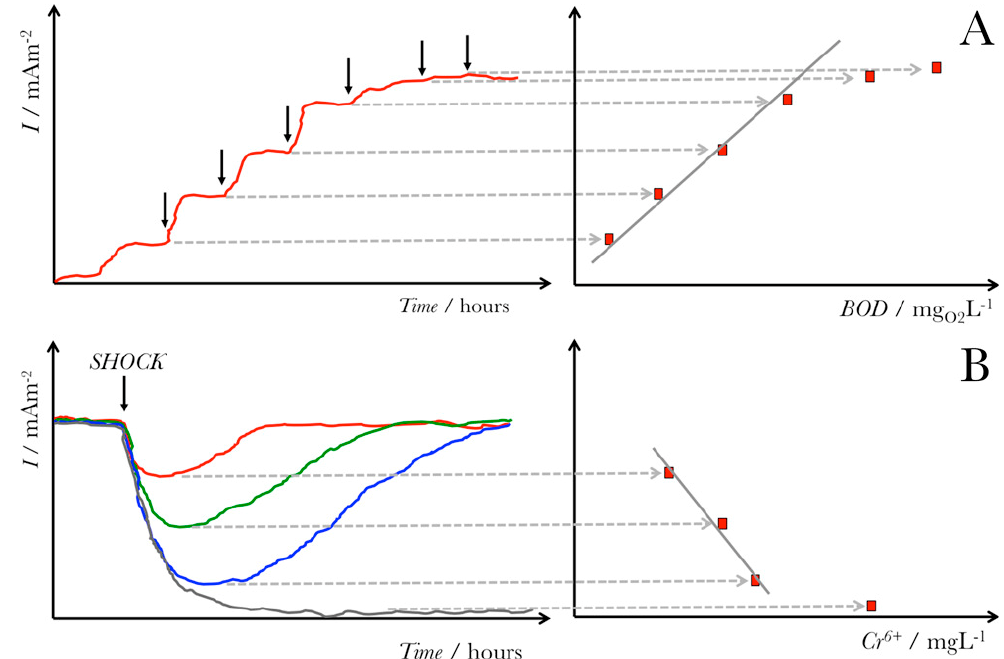
Figure 3. General scheme for microbial electrochemical sensors. Panel ( A ) shows how a microbial electrochemical sensor would work to sense the organic content of a solution, such as the biological oxygen demand (BOD), using the current generation. Panel ( B ) shows how a microbial electrochemical biosensor would sense a toxic contaminant such as chromium (V) in a solution based on the current decrease from the inhibition of microbial metabolic current generation, limited by the maximum concentration of Cr 5+ that would produce an irrecoverable current drop from the death of bacterial cells. Reproduced with permission from M. Grattieri and S.D. Minteer. Self-Powered Biosensors. ACS Sens. 2018, 3, 44–53 [9]. Copyright 2018 ACS.